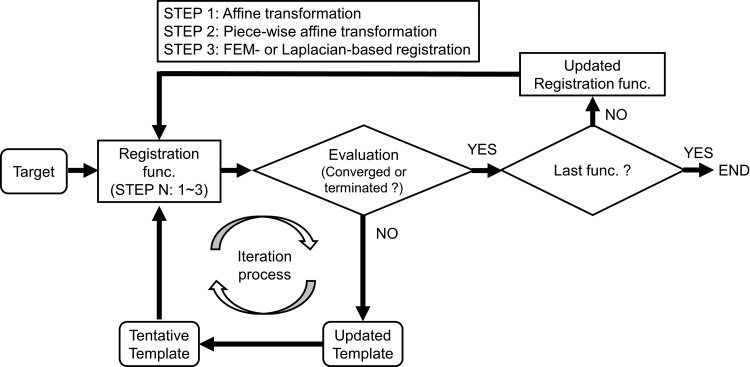
The schematic flow of registration. At STEP 1, the template models were updated until the convergence criterion or termination criterion was met. The convergence criterion was that the average mean bidirectional difference between after the end of the k – 1th loop and after the end of the kth loop in the most recent 10 iterations was <0.001 mm. Otherwise, the iteration process was terminated when the optimization calculation completed the 3000th iteration. When the convergence criterion or termination criterion was met, the iteration process for STEP 1 was terminated, and the iteration process for STEP 2 was then initiated. These processes were repeated until the convergence criterion or termination criterion was met in the last STEP. Once registration was completed for one target model, the iteration process was initiated for the next target model.